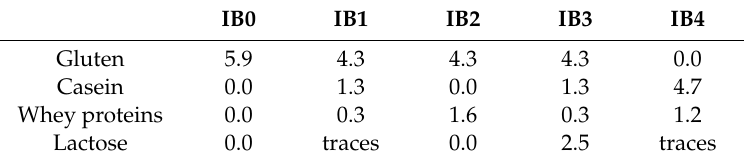
Table 2. Type and quantity of protein and lactose content (g / 100 g) of experimental